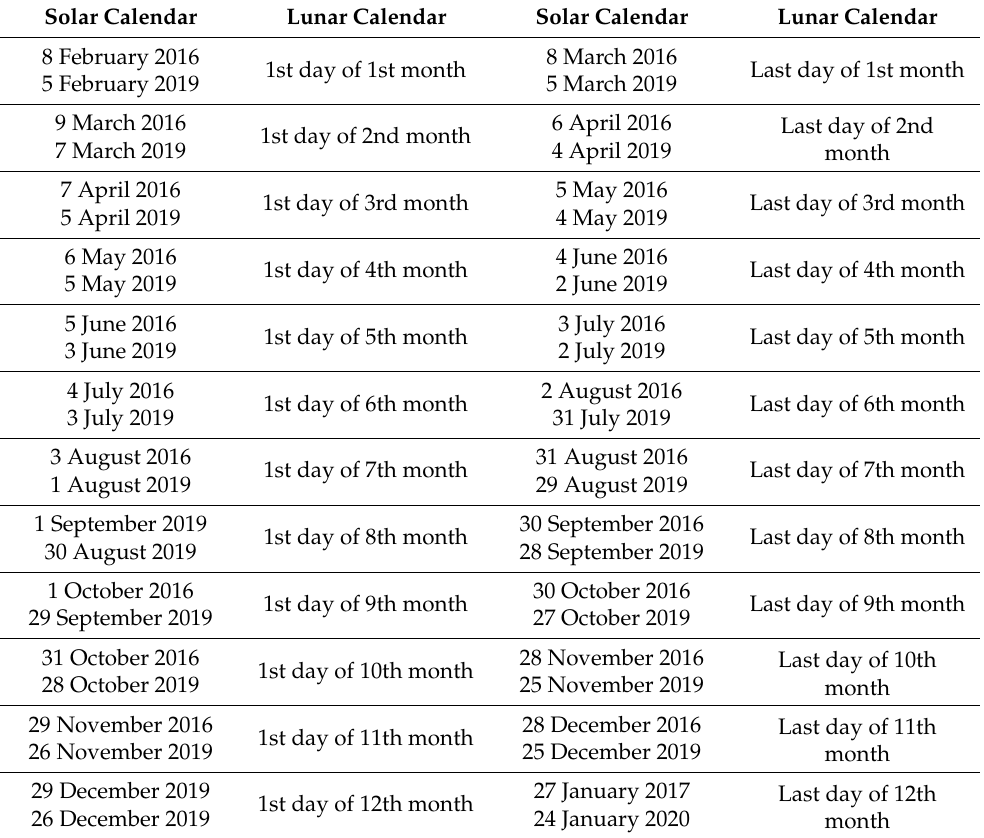
Table A1. Comparison between the solar and lunar calendars of 2016–2017 and 2019–2020. Solar Calendar Lunar Calendar Solar Calendar Lunar